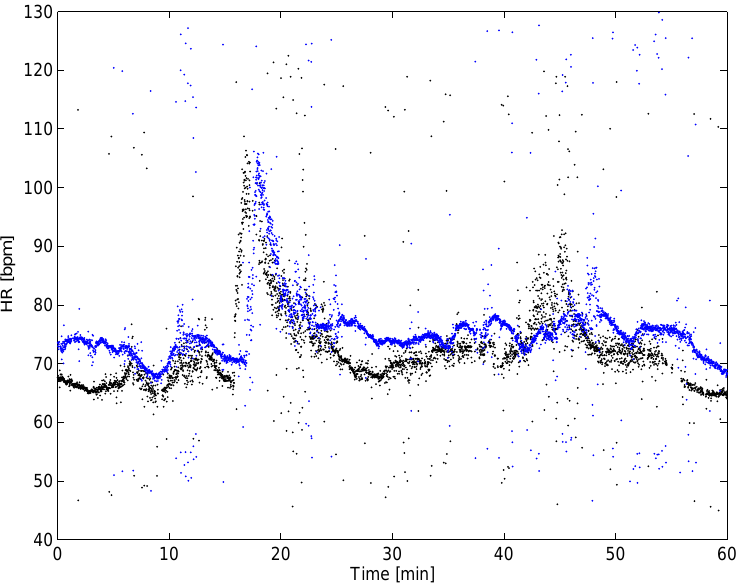
Figure 12. Heart rate (HR) of a study participant during gymnastics in two periods: September 2017 (black) and November 2017